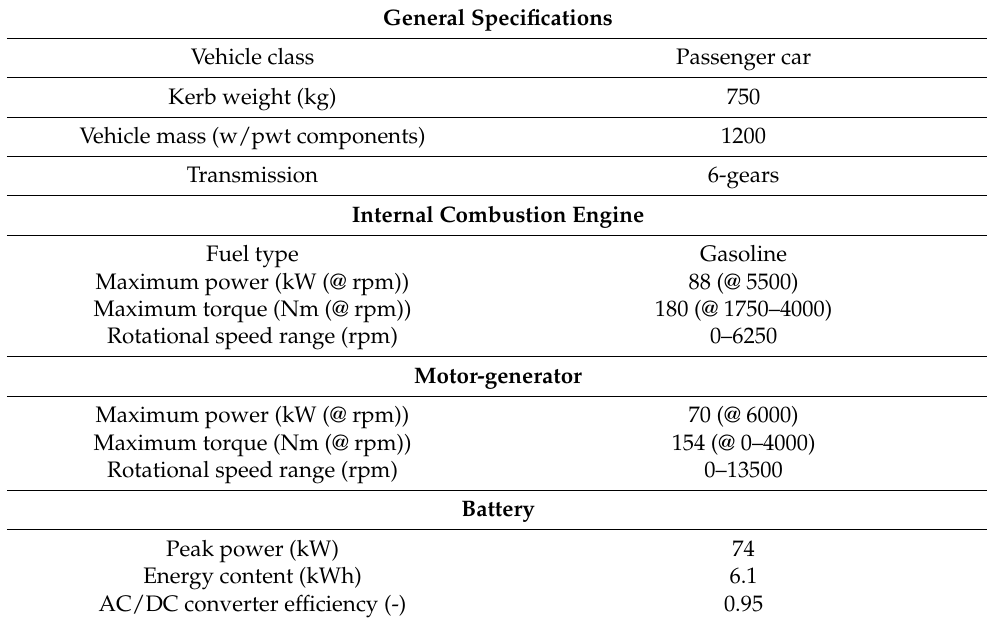
Table 1. Characteristics of the main vehicle and powertrain